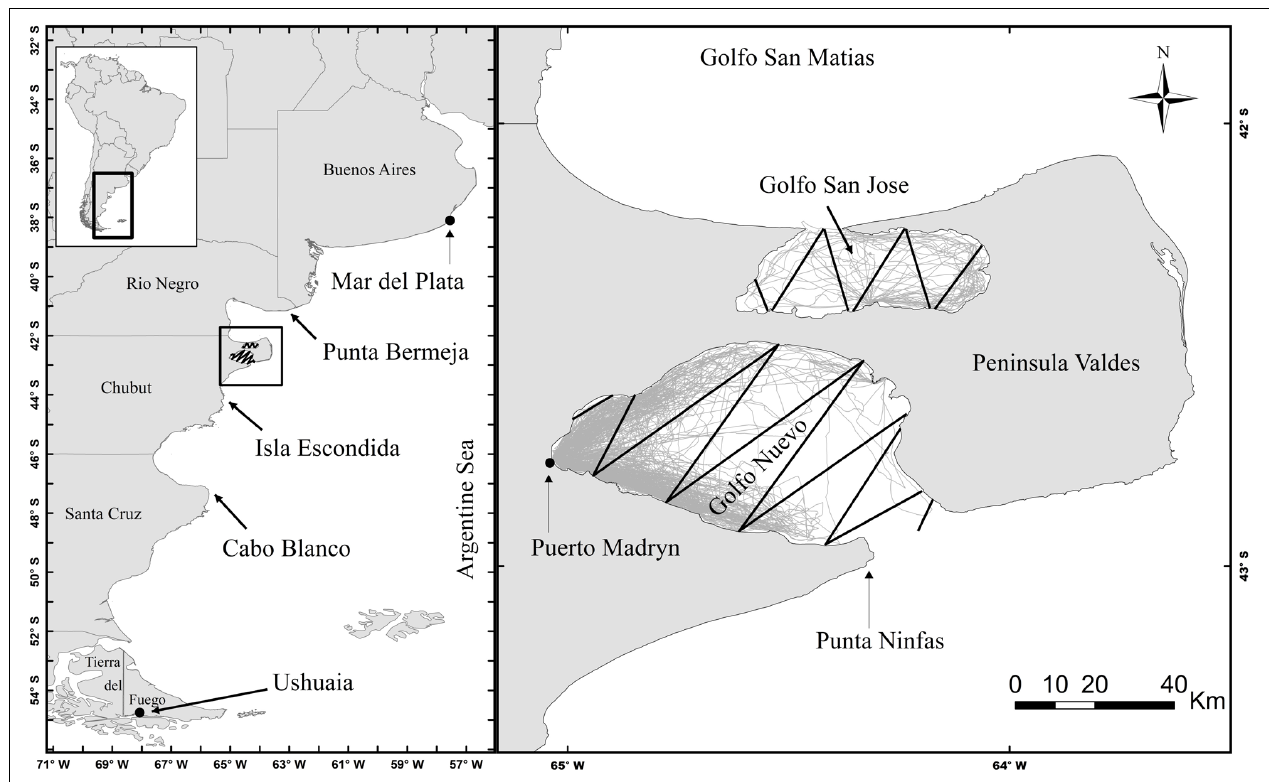
FIGURE 1 | Study area with the line transect covered by aerial surveys in black and trackline of the vessel-based surveys in gray, in Golfo Nuevo and Golfo San José.